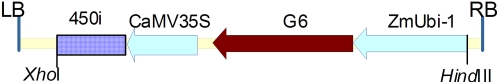
Diagram of the T-DNA fragment of the binary plasmid pG6-450i for Agrobacterium transformation.ZmUbi-1, Zea mays polyubiquitin-1 promoter; CaMV35S, cauliflower mosaic virus 35S promoter; G6, the 5-enolpyruvylshikimate-3-phosphate synthase isolated from Pseudomonas putida fused with chloroplast transit peptide at the N-terminus (gb: EU169459); R450i, the inverted repeat sequence of the 207bp fragment of CYP81A6; LB and RB, left and right border of the T-DNA.